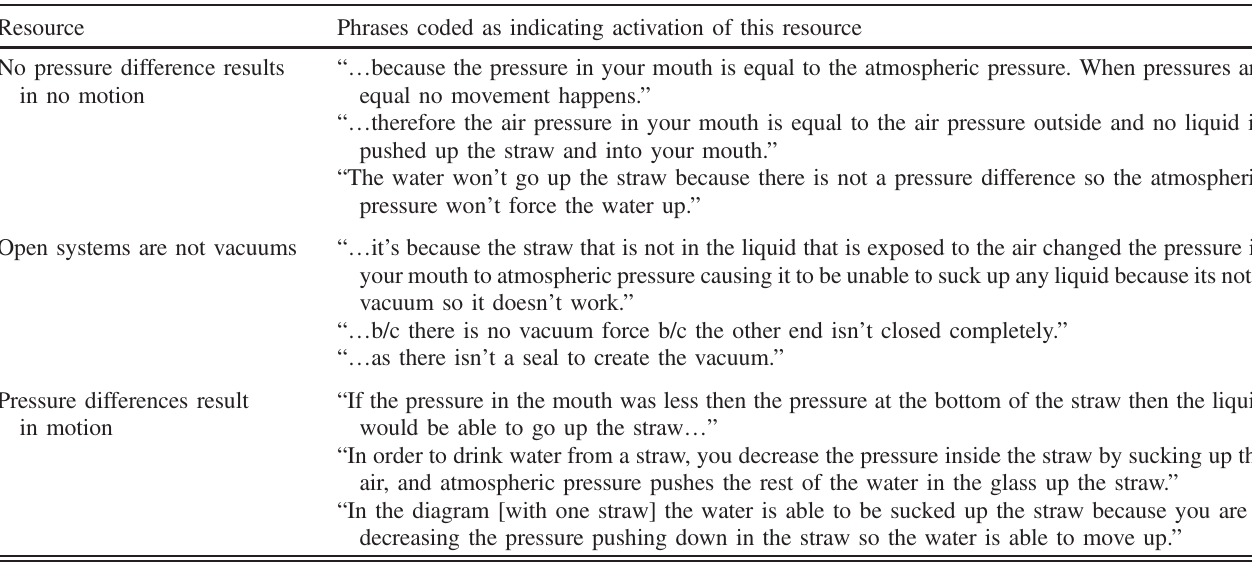
TABLE VIII. Evidence for resources for double straw problem. Resource Phrases coded as indicating activation of this resource